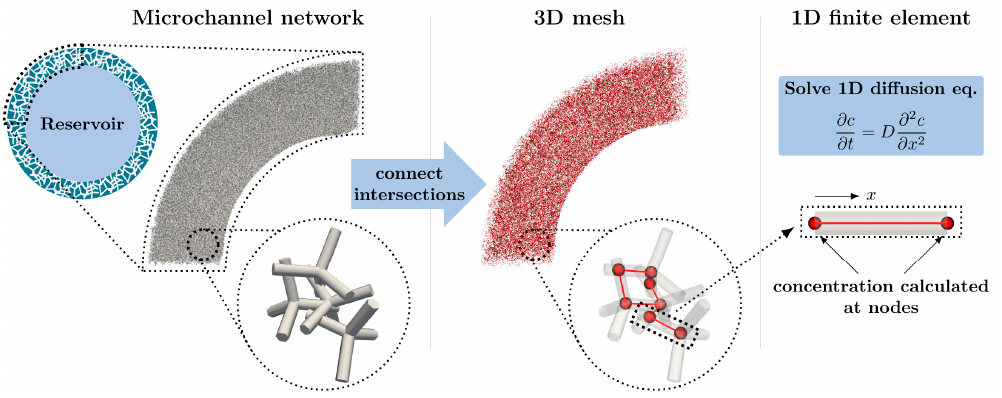
Figure 2. Schematic of the computational model, and simulation of the reservoir-based drug deliv- ery system.